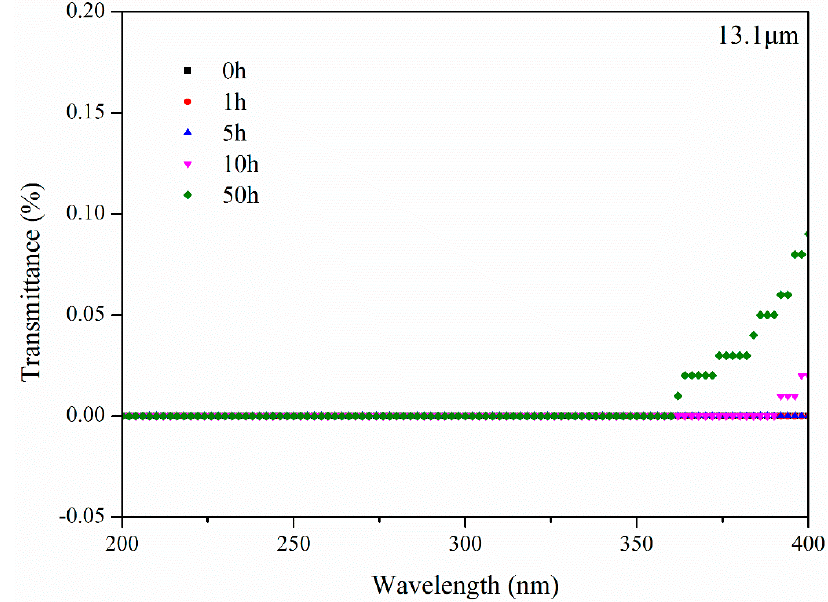
Figure 16. Transmittance of bitumen with 13.1 μ m thickness after UV aging for different aging times.